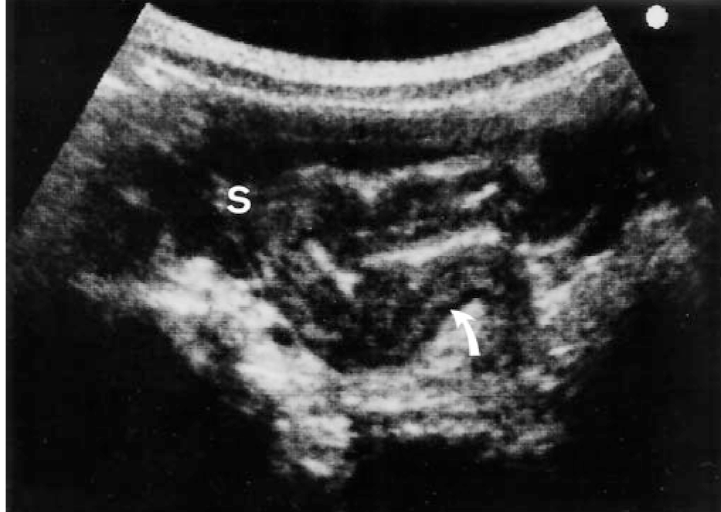
Figure 2. Evaluation of lower abdomen of pediatric patient with Salmonella enterocolitis using transverse ultrasound. There is thickening of the sigmoid colon which results predominantly from submucosal edema (arrow) observed as the thick hyperechoiclayer. S = sigmoid colon [72].